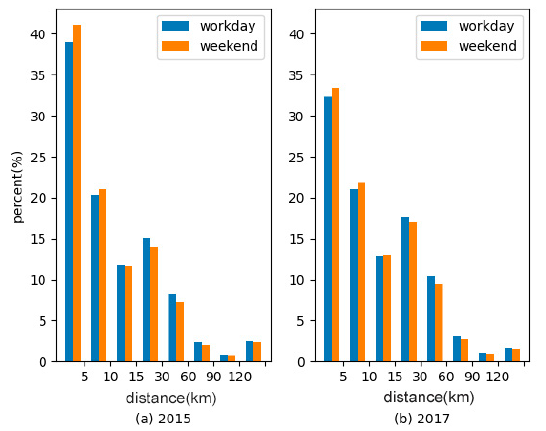
Figure 5. Frequency distribution of the distance of unoccupied trips in ( a ) 2015 and ( b ) 2017.